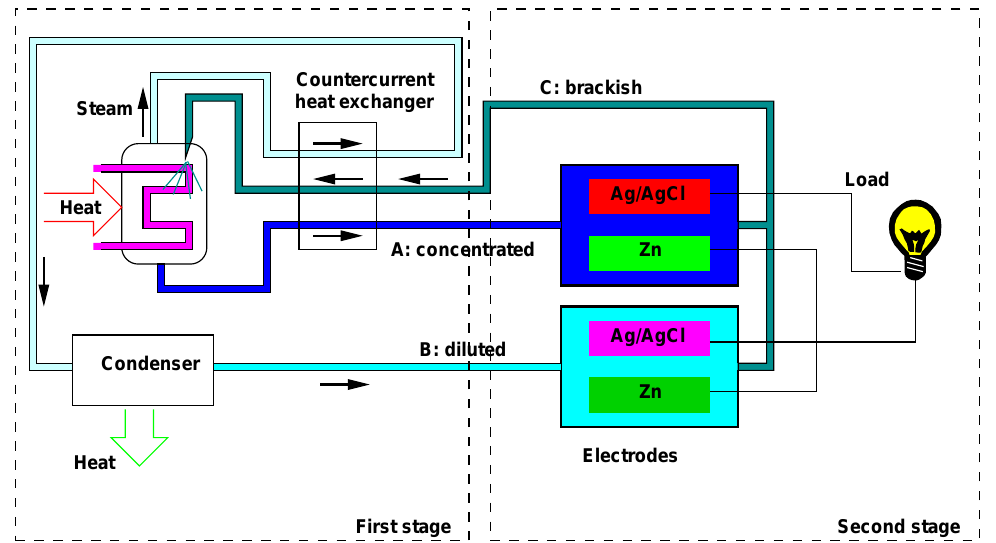
Figure 1. Sketch of the heat-to-current converter system. The electrochemical cells consume the concentration difference between two flows, A and B, using the available free energy for producing an electrical current. The concentrations are then restored by means of a distiller, which consumes heat. The system is thus a heat-to-current